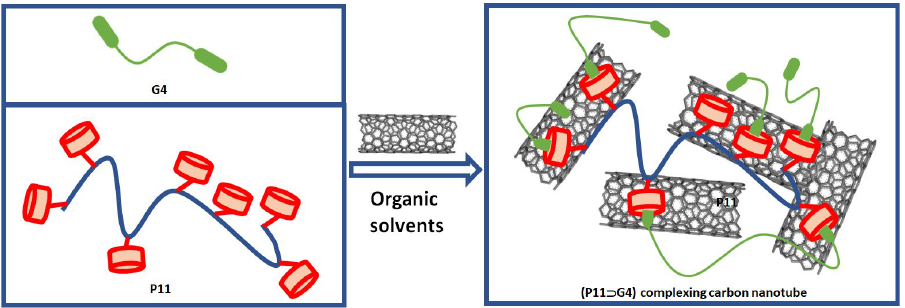
Figure 2. Illustration of dispersing and gelating carbon nanotube by using host–guest inclusion P11 ⊃ G4 in 1,2-dichlorobenzene [85].